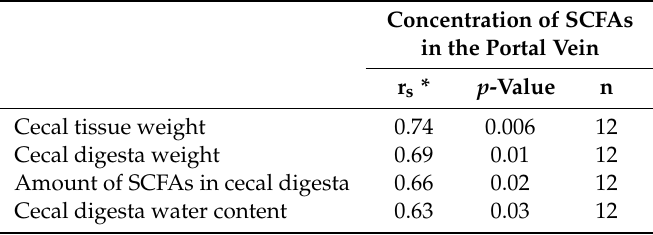
Table 5. Correlation between the short-chain fatty acid (SCFA) concentration in the portal vein and the cecal tissue weight, cecal digesta weight, amount of SCFAs in cecal digesta, and cecal digesta water